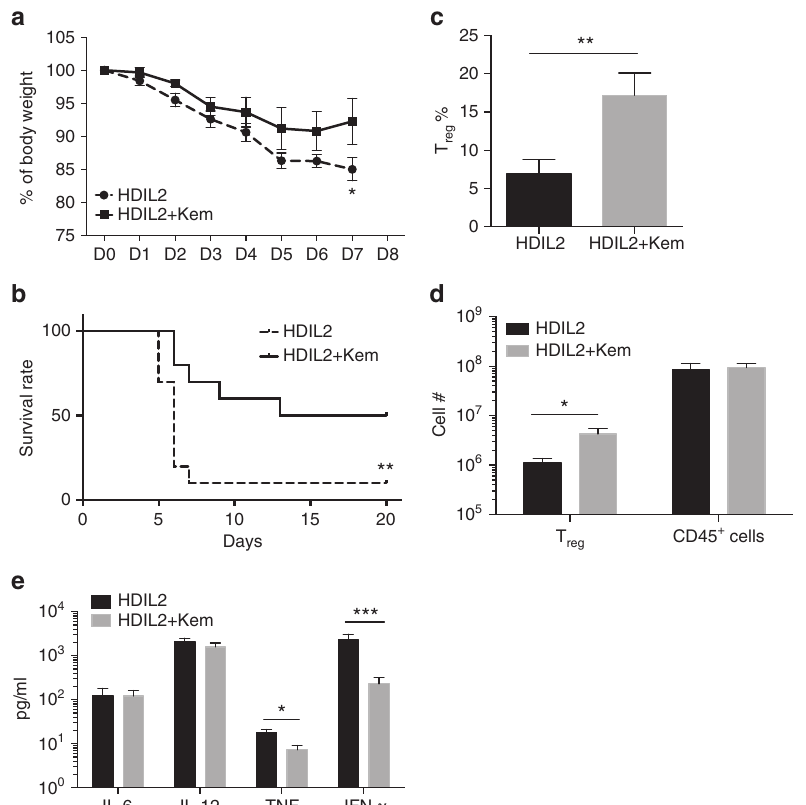
Fig. 7 Kaempferol ameliorates high-dose IL-2 induced toxicity through regulatory T cells. High-dose IL-2 (HDIL2) human immune system (HIS) mice were analyzed at D8 after 30 μ g IL-2 plasmid injection. a Percentages of body weight change after HDIL2 treatment with or without Kaempferol ( n = 5 per group). The data are representative of three independent experiments. Comparison between HDIL2 HIS mice and Kaempferol-treated HDIL2 HIS mice by repeated-measures two-way ANOVA with a Sidak test. b Kaplan − Meier survival curves of HDIL2 HIS mice and Kaempferol-treated HDIL2 HIS mice ( n = 12 for HDIL2 group n = 10 for HDIL2+ kem group) were analyzed by Log-rank test. c Percentages of CD25 high CD127 − Foxp3 + cells within splenic CD45 + CD3 + CD4 + T cells. d Absolute cell counts of human regulatory T cells and total CD45 + cells in spleens of indicated groups. e IL-6, IL-12, TNF and IFN- γ levels were analyzed from sera of HIS mice from corresponding groups. Data are pooled from three independent experiments and analyzed by Mann − Whitney test. * P < 0.05, ** P < 0.01, *** P <